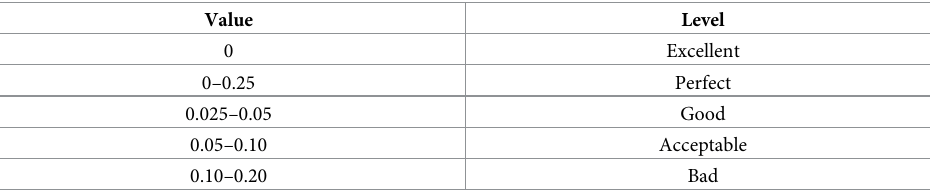
Table 6. STRESS evaluation criteria [own elaboration based on